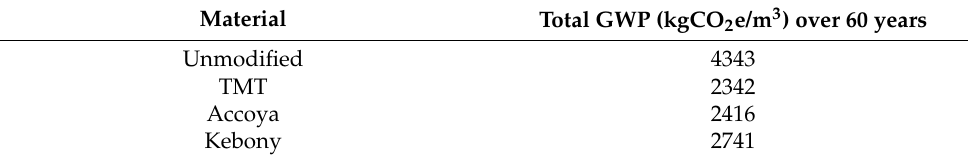
Table 8. The total GWP impact associated a reference service life of 60 years. For the unmodified wood, a lifetime of 20 years was assumed, and coatings were applied every five years. For the modified wood, a lifetime of 60 years was assumed, and coatings were applied every 10